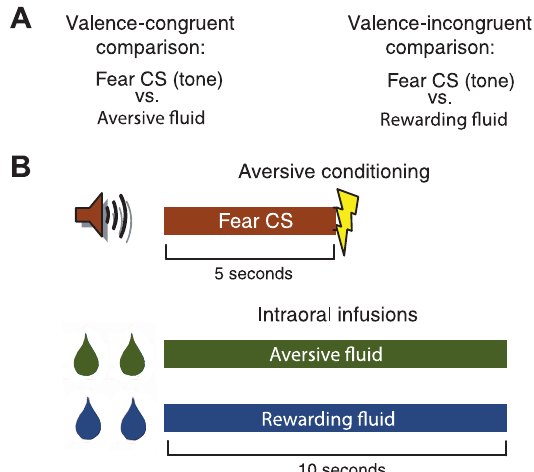
Figure 1. Experimental design and methods. ( A ) Experimental design. If the BLA encodes emotional valence during learned fear, then neuronal activity should be more similar during the fear CS and aversive fluid infusion (valence-congruent comparison) than during the fear CS and rewarding fluid infusion (valence-incongruent comparison). ( B ) Methods. Neuronal activity during the 5 second fear CS was compared to neuronal activity during the first 10 seconds of the rewarding and aversive intraoral fluid infusions.